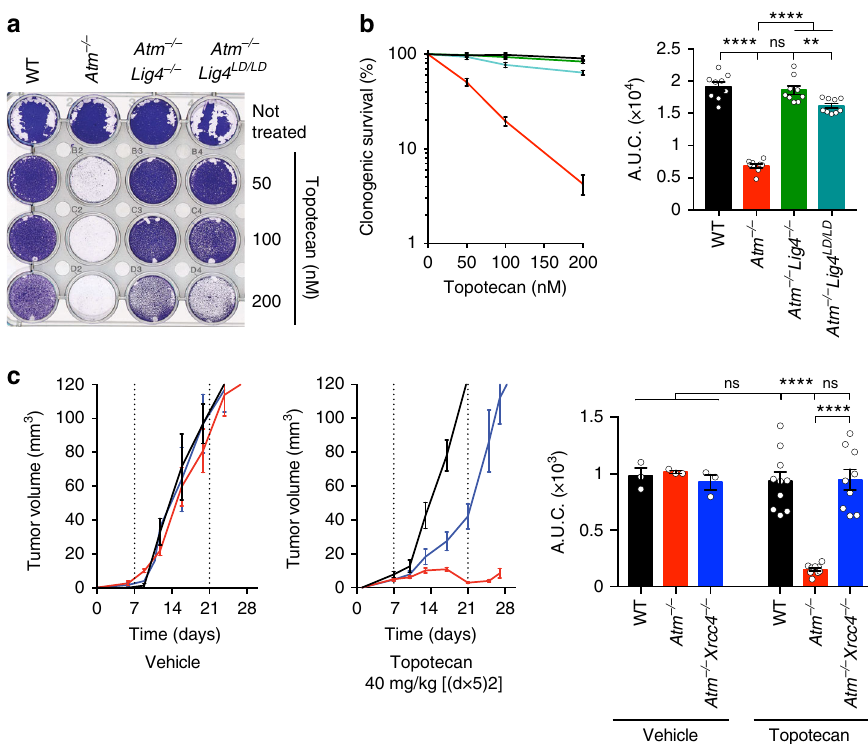
Fig. 3 LIG4 catalytic activity mediates topotecan sensitivity in ATM-de fi cient cells. a Crystal violet cell viability assay shows that LIG4 catalytic activity mediates hypersensitivity of ATM-de fi cient cells to topotecan. LD ligase-dead allele. b Quanti fi cation of clonogenic survival assays indicating suppression of Atm − / − ( n = 9) cell hypersensitivity to topotecan upon abrogation of LIG4 catalytic activity in Atm − / − Lig4 LD/LD ( n = 9) as compared to WT ( n = 9) and Atm − / − Lig4 − / − ( n = 9). Data from n = 3 individual experiments. c Mouse xenograft studies indicating that Atm − / − Xrcc4 − / − -de fi cient tumors are more resistant than Atm − / − single mutant tumors to 40 mg kg − 1 topotecan treatment (days 1 – 5 and 8 – 12 equivalent to [( d ×5)2] schedule via